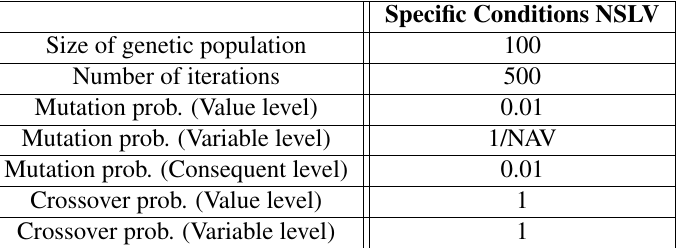
Table 4. Specific conditions for NSLV. NAV means the number of antecedent